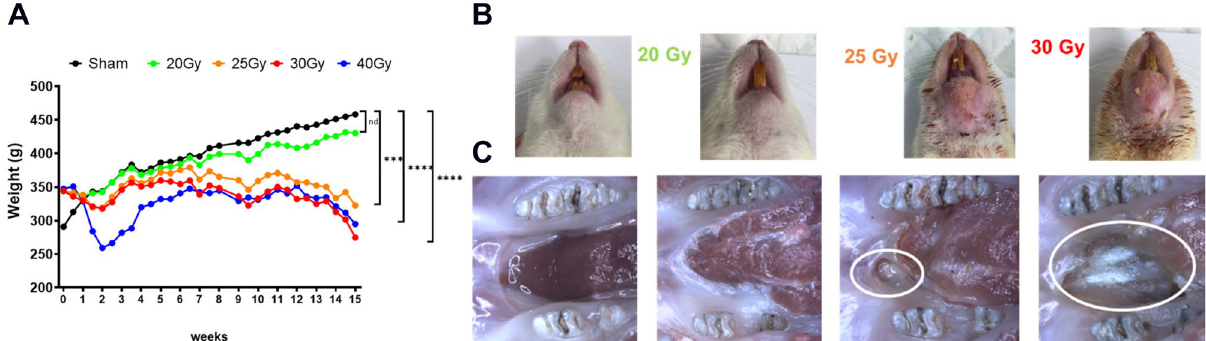
Figure 1. Clinical follow-up of animals according to irradiation dose. ( A ) Animal weight curves. Statistical analysis: Friedman non-parametric test. ( B ) Representative pictures of external cutaneous damage. ( C ) Representative pictures of buccal damage after explantation. Mucosal ulcers and bone exposure are highlighted by white